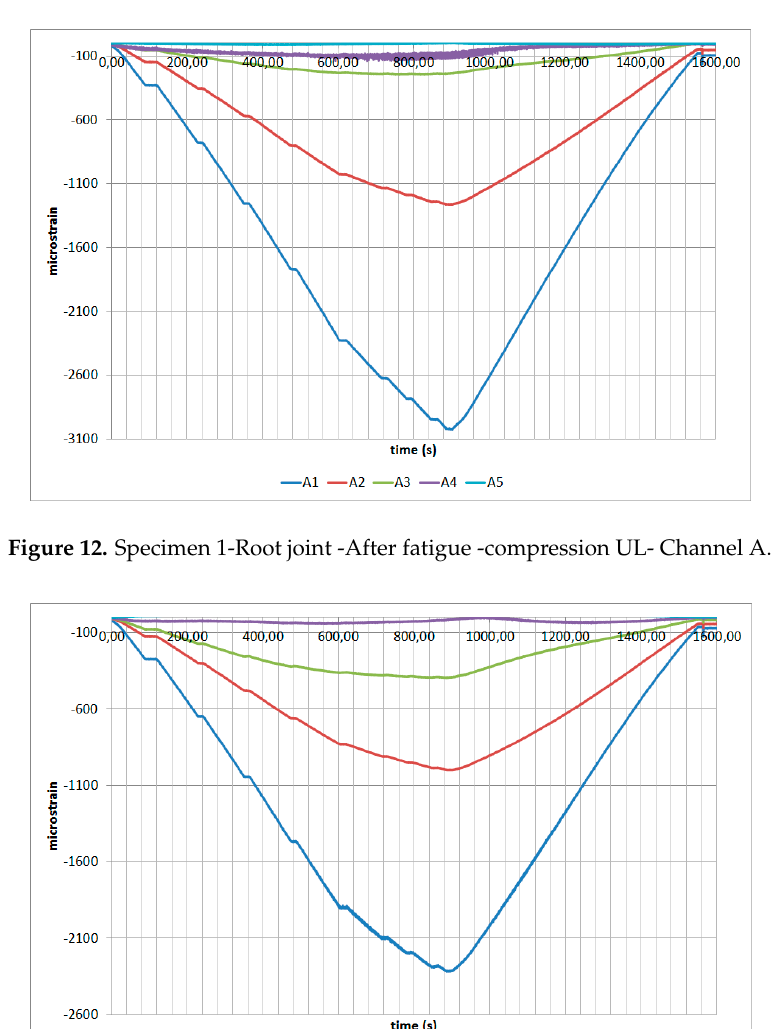
Figure 11. Specimen 1-Root joint -Before fatigue -tensile LL- Channel D.